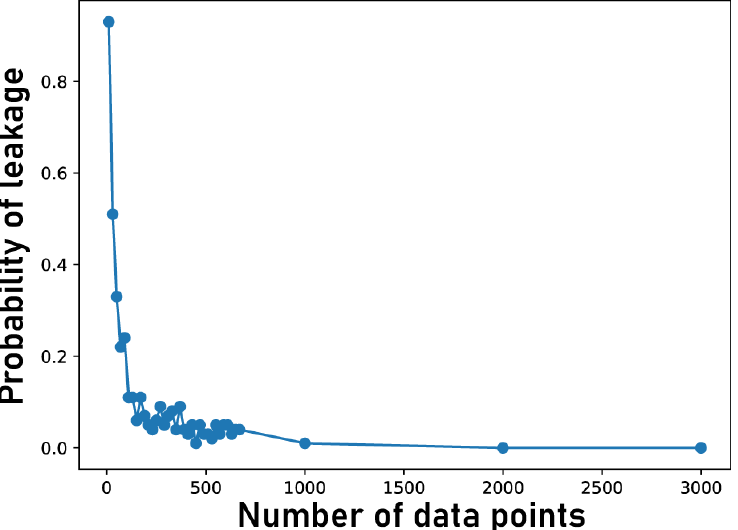
Figure 20. Mock stellar light curve test results for the leakage effect. Along the x -axis is the number of data points provided to Fourier transformation. The data points have equal time intervals with a total length of 4 years, distributed as a sine function. The period of the sine function is shorter than 0.5 years. The y -axis is the probability of finding a signal between 0.5 and 6 years that passes the p -value